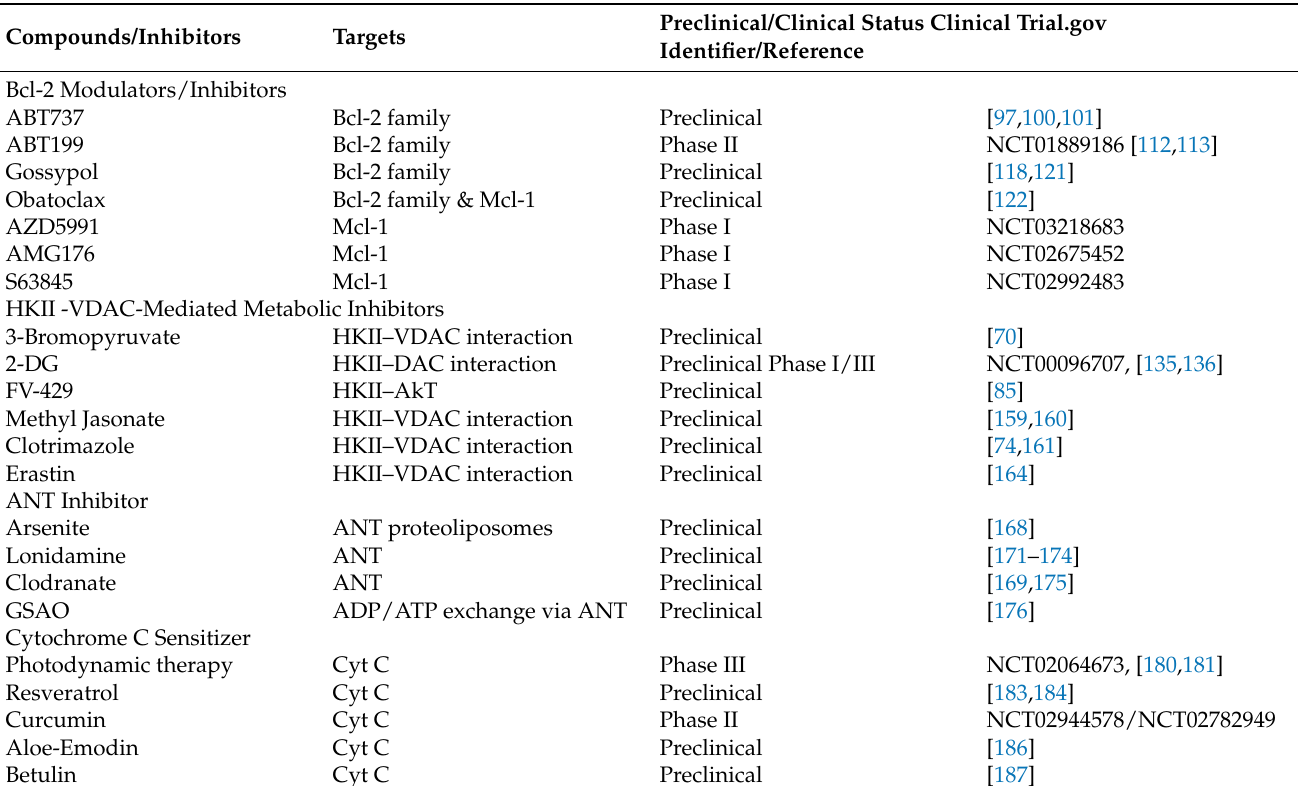
Table 1. Overview of the clinical trials of drugs targeting mPTP-mediated apoptotic cascade in